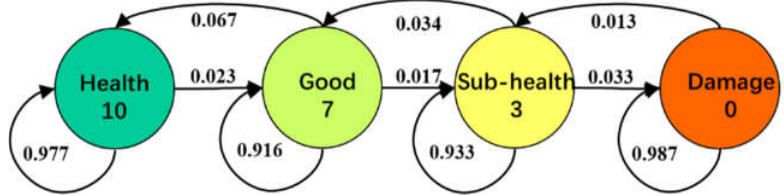
Figure 9. Markov Decision Model.